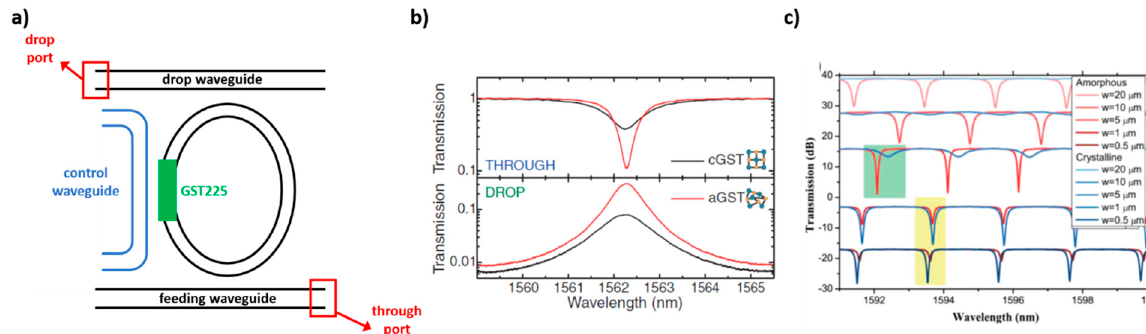
Figure 14. ( a ) Examples of a commonly employed architecture for the preparation of memory cell, composed of a ring resonator containing a switchable GST225 unit, a feeding waveguide and a drop waveguide. In the work of Pernice et al. a control waveguide is used to induce phase transition [112]; ( b ) variation of transmission recorded at the through port (up) and at the drop port (bottom) upon GST225 switching. Laser pulses are used to induce phase transition [50]; ( c ) variation of transmission at the through port upon GST225 switching, according to different width values of the GST225 patch. It is possible to modify the ring resonator parameters (radius and gap with the feeding waveguide) in order to obtain “direct switching”, as highlighted in the green region, and “inverse switching”, as highlighted in yellow regions [113]. Reproduced from Refs. [50,113] with permission from Wiley.